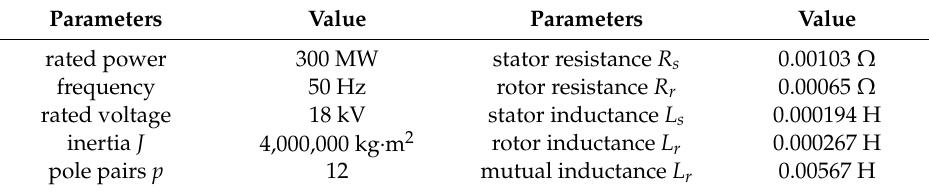
Table 1. Parameters of